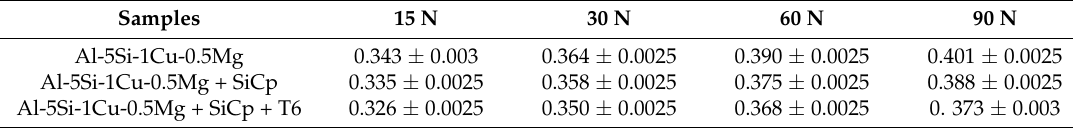
Figure 8. Coefficient of friction (COF) values for samples under various applied loads. Table 3. Detailed Coefficient of friction (COF) values for samples at various applied